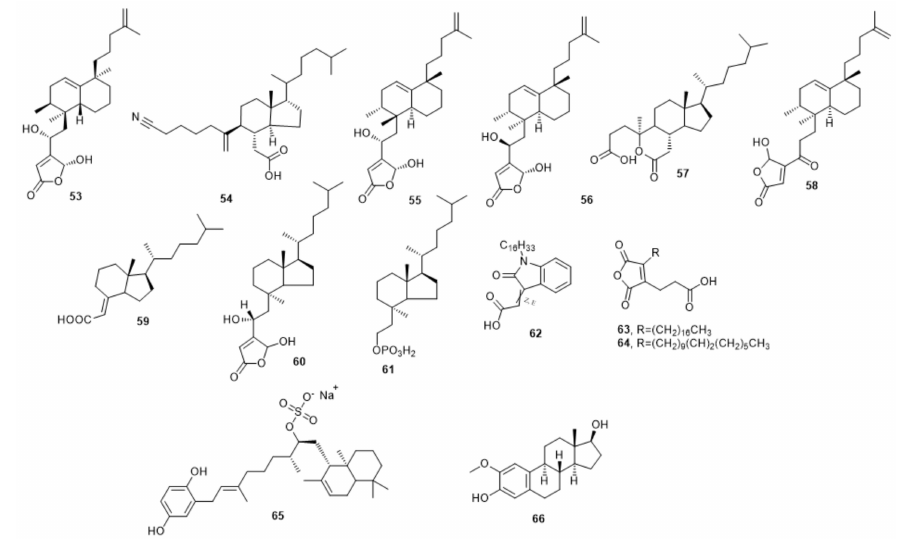
Figure 7. Cdc25 inhibitors based on steroid- and dysidolide-like